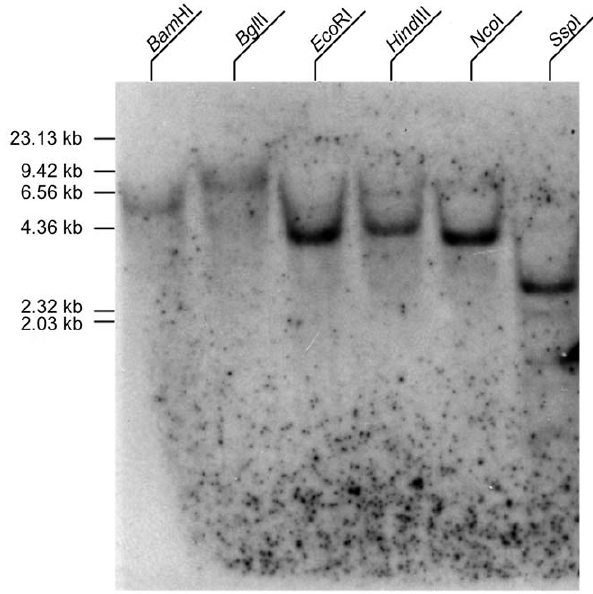
Figure 3. Southern blot of digested genomic DNA for the identification of the copy number of Ba-CaM gene. Genomic DNA was digested with various restriction enzymes including Bam HI, Bgl II, Eco RI, Hind III, Nco I, and Ssp I. doi:10.1371/journal.pone.0031337.g003 one of the CaMKII inhibitors, did not show any significant effect ranging from the concentrations of 0.125 m M to 10 m M (Fig. 6C); whereas, AIP, another CaMKII inhibitor tested in this study, partially inhibited cyprid settlement at concentrations higher than 5 m M (Fig. 6D).